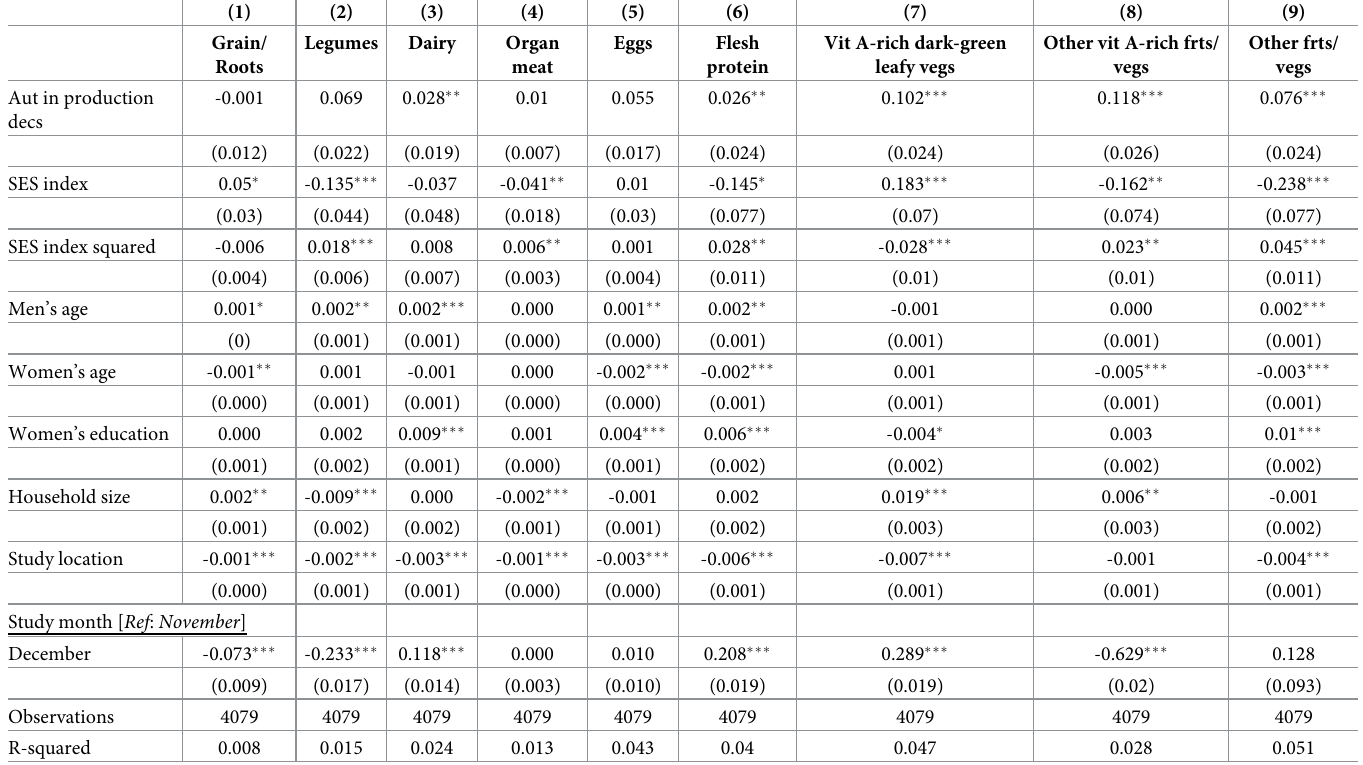
Table 17. LPM regression for food groups consumed–production domain (input in � 2 productive